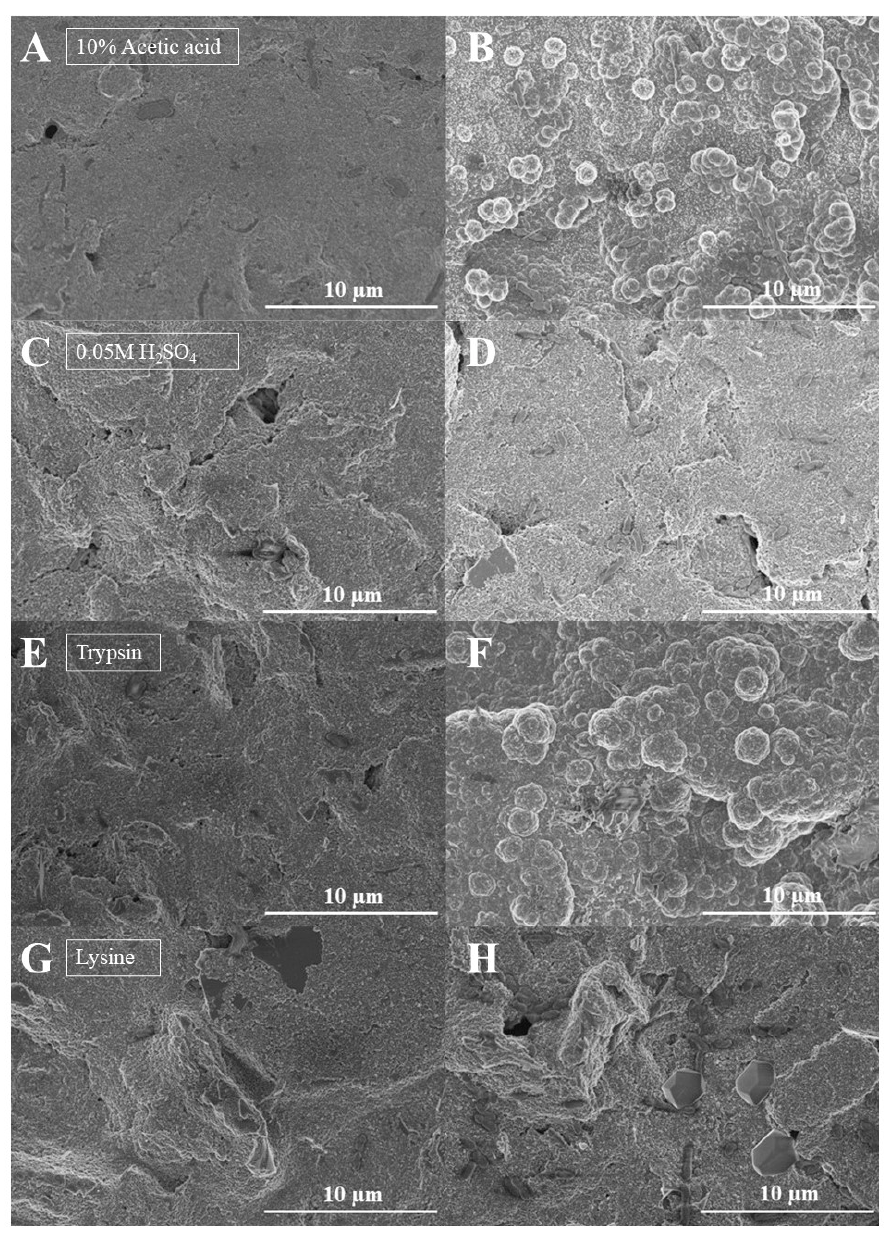
Figure 3. SEM images of NIP-Ppy/SPCE ( A , C , E , G ) and MIP-Ppy/SPCE ( B , D , F , H ) electrodes after incubation in different template extraction solutions: ( A , B ) 10% acetic acid, ( C , D ) 0.05 M sulphuric acid, ( E , F ) 10 U/mL trypsin, ( G , H ) 0.1% L-lysine at 37 °C for 30 min.